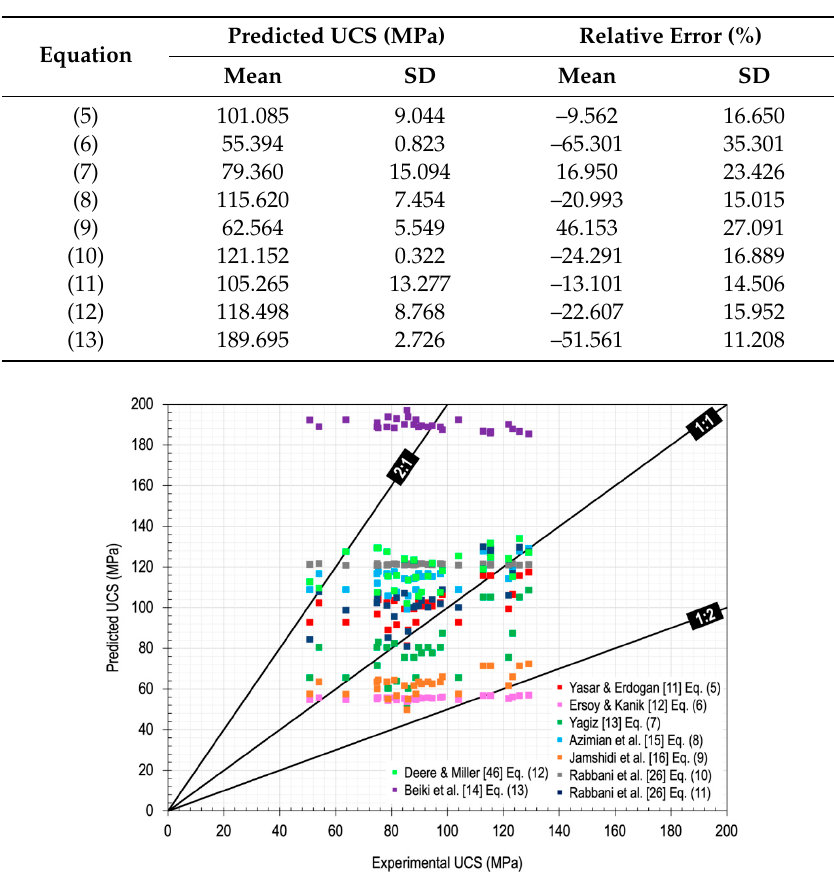
Table 3. Average obtained UCS values in strength tests and average predicted UCS values, as well as their relative errors according to di ff erent authors.